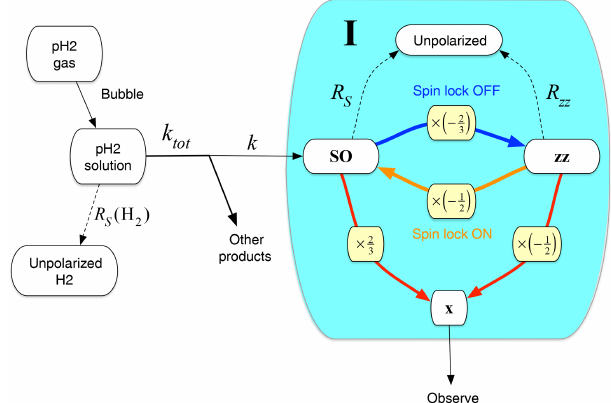
Figure 6. Kinetic model for gem -PHIP. The chemical reaction of para -enriched H 2 with the acetylenedicarboxylate precursor and ruthenium-based catalyst (not shown) proceeds with rate constant k . The shaded area includes the product molecule I in different spin polarization states: unpolarized (top), in a state of singlet nuclear spin order (left), in a state of zz order (right), and with observable x magnetization (bottom). Singlet order decays with rate constant R S = T − 1 ; zz order decays with rate constant R zz = T − 1 zz . If no S spin-locking field is present, singlet order is rapidly converted into zz order, with a conversion factor of − 2 / 3 (blue arrow and yellow box). If a spin-locking field is applied, zz order is instantaneously projected onto singlet order, with a conversion factor of − 1 / 2 (or- ange arrow and yellow box). Singlet order and zz order may be con- verted into observable x magnetization by the two-pulse sequence in Fig. 3 (red arrows and yellow boxes). The conversion factors in this case are 2 / 3 for singlet order and − 1 / 2 for zz